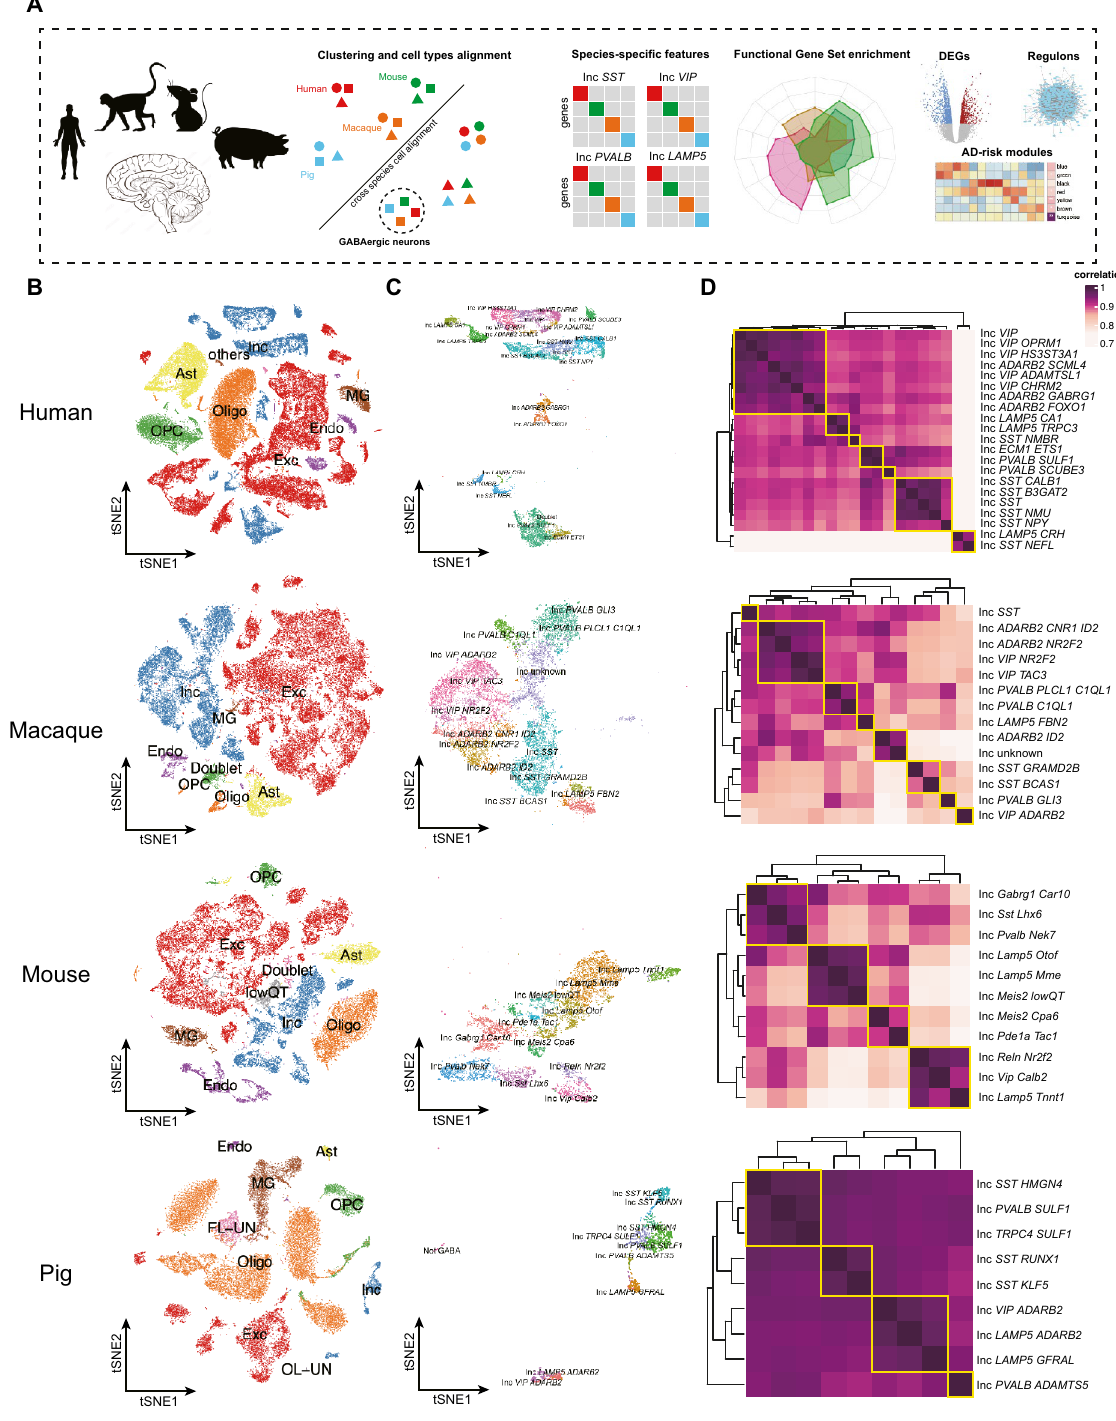
Figure 1. Cell type heterogeneity across species. ( A ) Pipeline of article design and data analysis. ( B ) The t-SNE plots show the major cell types in human, macaque, mouse, and pig. Exc, Excitatory neuron; Inc, Inhibitory neuron; MG, Microglia; Endo, Endothelial cells; OPC, Oligodendrocyte progenitor cells; Oligo, Oligodendrocytes; Ast, Astrocytes. ( C ) The t-SNE plots show the subtypes of GABAergic neurons in human, macaque, mouse, and pig. ( D ) The heatmaps show the correlation of different GABAergic neurons subtypes in human, macaque, mouse, and